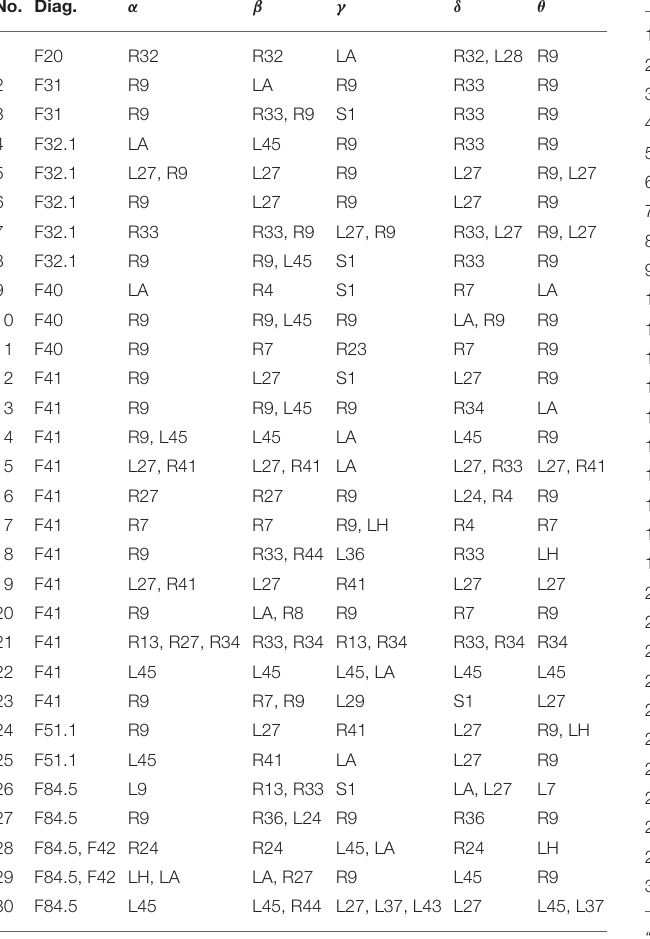
TABLE 2 | The most active BA in particular subjects of control group during the digit-span task experiment in the alpha, beta, gamma, delta and theta EEG bands. No. α